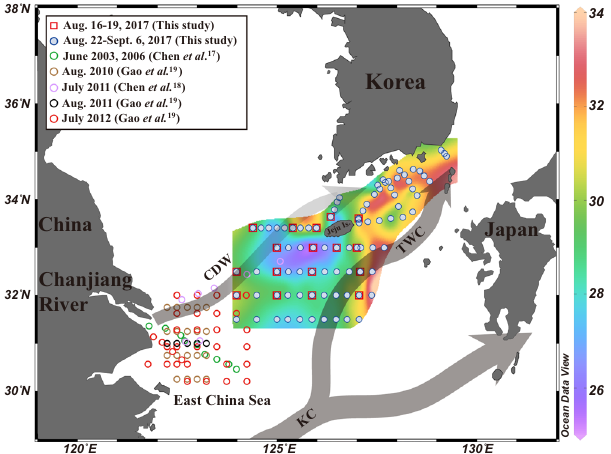
Figure 1. Map showing sampling stations and schematic patterns of surface currents in the northwestern Pacific marginal seas during the summer. The solid arrows represent the surface currents, such as the Changjiang diluted water (CDW), the Kuroshio Current (KC), and the Tsushima Warm Current (TWC) originating from KC. Open circles denote reference stations obtained from Chen et al . 17,18 and Gao et al . 19 . Contour map denotes horizontal distribution of salinity in surface waters of the East China Sea from August 22 to September 6, 2017. The contour map was created using Ocean Data View software version 5.0.0.